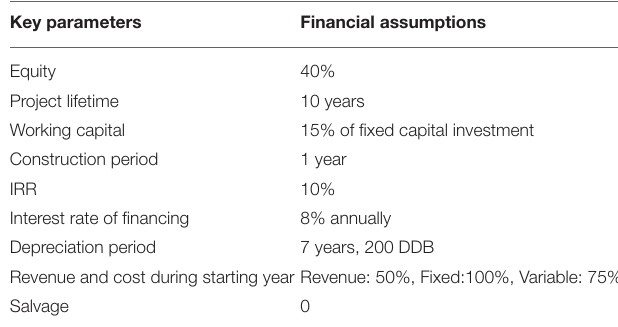
Pyrolysis products and (intermediates) Key